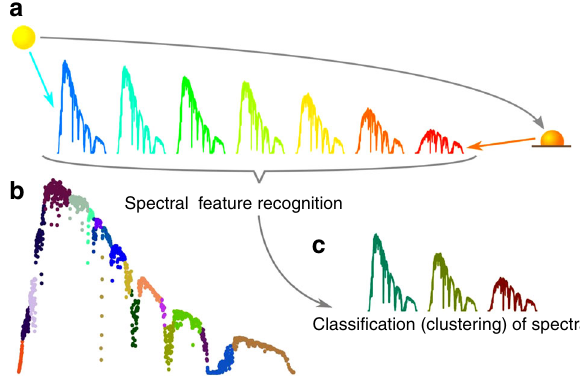
Fig. 1 Visualization of the method. a The solar spectra depend on the position of the sun and atmospheric phenomena. We reduce yearly spectral sets with 2 × 10 4 solar spectra to a few characteristic proxy spectra. b The main features of the spectra are identi fi ed using structured feature agglomerative clustering as an unsupervised dimensionality reduction step. A set of 20 automatically identi fi ed features is shown in this example. c Spectra with the most similar features are then clustered together into a small set of proxy spectra using the k -means method